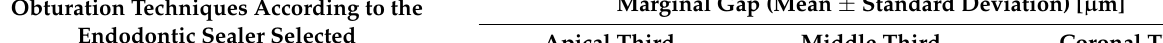
Table 2. Schematic representation of marginal gap measurements divided according to the endodontic sealer (AH Plus Bioceramic Sealer (AHP), EndoSequence BC Sealer HiFlow (ES), C-Root SP (CR), and GuttaFlow Bioseal (GF)) and the selected obturation technique (single-cone technique (SC) and thermomechanical condensation (TC)). In each column, means sharing the same letter are related by a statistically significant difference ( p <